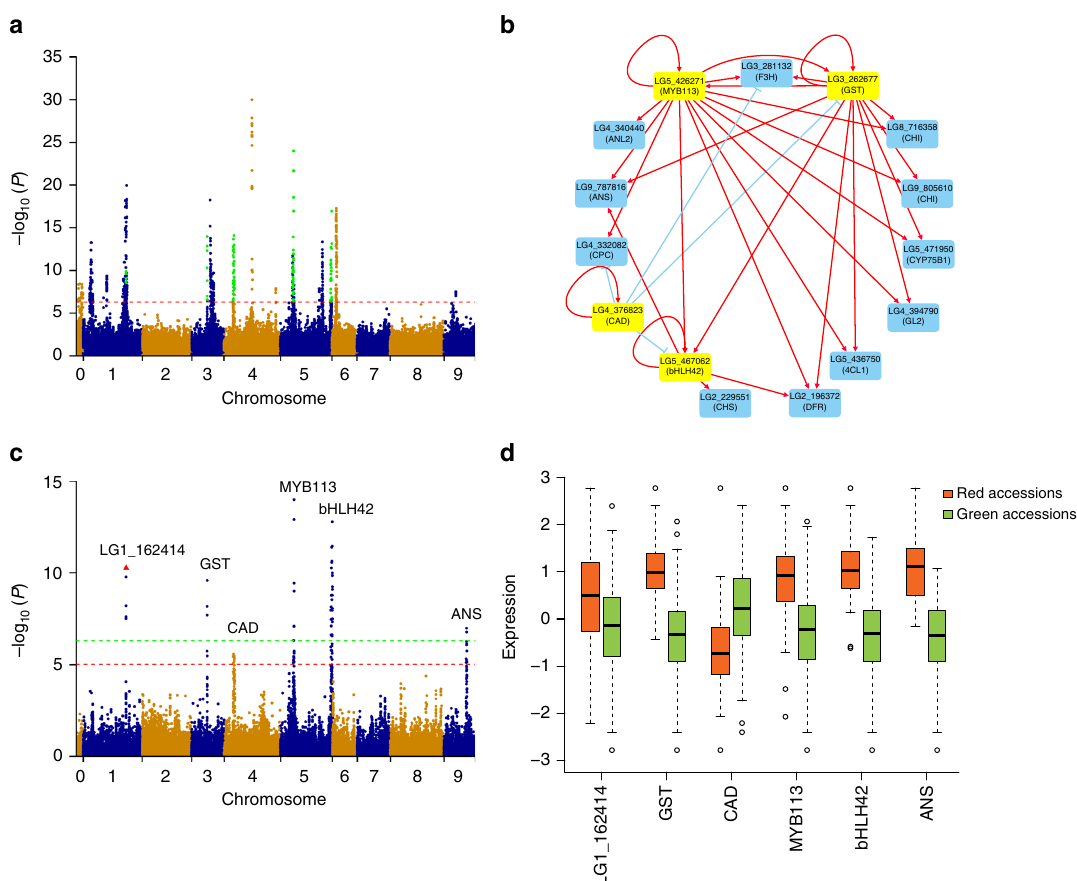
Fig. 5 Regulatory network of genes associated with fl avonoid biosynthesis. a Combined Manhattan plots from the eQTLs of 24 genes associated with fl avonoid biosynthesis. Green dots represent the signi fi cantly associated loci that were coincident with regions identi fi ed using the GWAS for the leaf anthocyanins. Chromosome 0 represents unanchored scaffolds. The red horizontal dashed line corresponds to the Bonferroni-corrected signi fi cance threshold ( − log 10 ( P ) = 6.31, α = 0.05). b The inferred regulatory network for fl avonoid biosynthesis using the iGA approach. Each node is a gene, and each edge is a predicted regulatory connection between genes. Yellow nodes represent candidate regulatory genes, and blue nodes represent the target genes. Red arrows indicate positive regulation, while blue bars indicate negative regulation. Cytoscape 70 was used to display the network. c Manhattan plot for leaf color. Six candidate genes are shown along the top of the signi fi cant associated signals. The red and green horizontal dashed lines correspond to the suggestive ( − log 10 ( P ) = 5.02, α = 0.1) and signi fi cant ( − log 10 ( P ) = 6.32, α = 0.05) threshold, respectively. The red triangle indicates the proposed functional site (1_125530709) in gene LG1_162414 . d The identi fi ed six candidate genes were signi fi cantly ( P ≤ 7.8 × 10 − 4 for all six candidates) differentially expressed between red and green accessions. The expression values of each gene were normal quantile